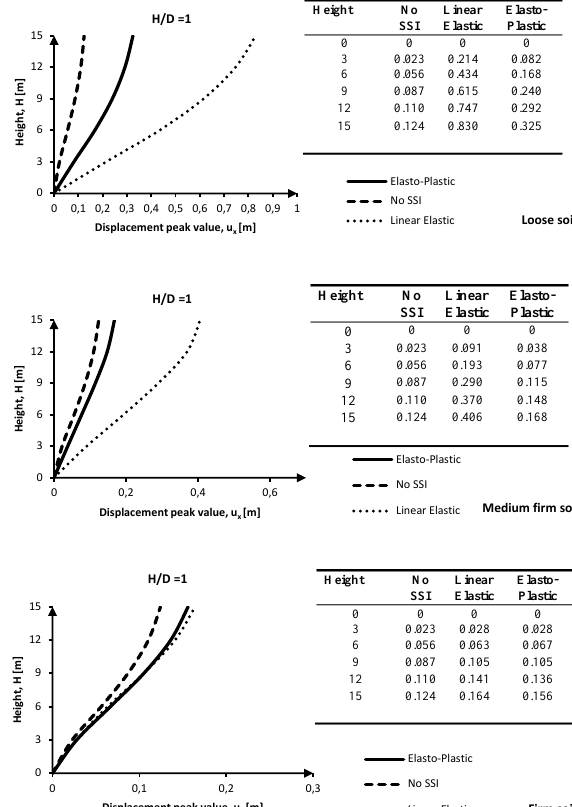
Table 4. Displacement and acceleration peak values for different points (constant with L =